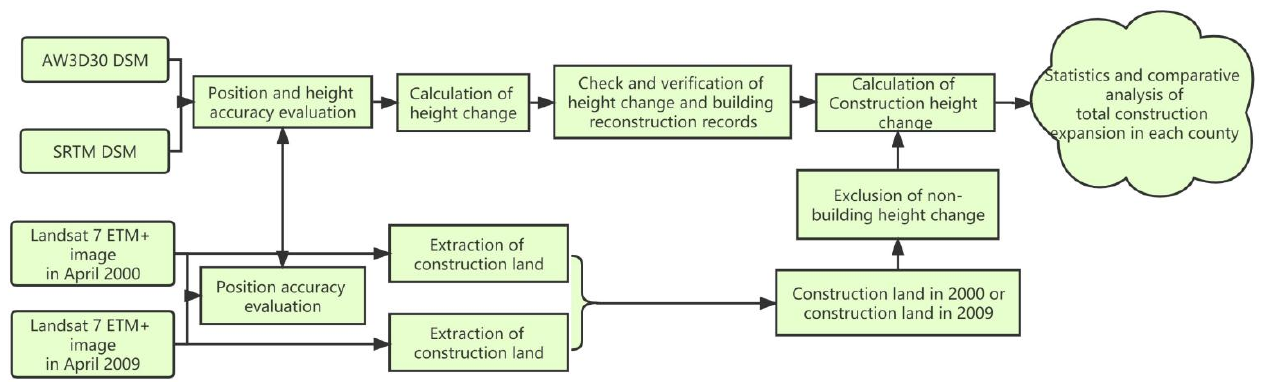
Figure 2. Methodology flowchart.